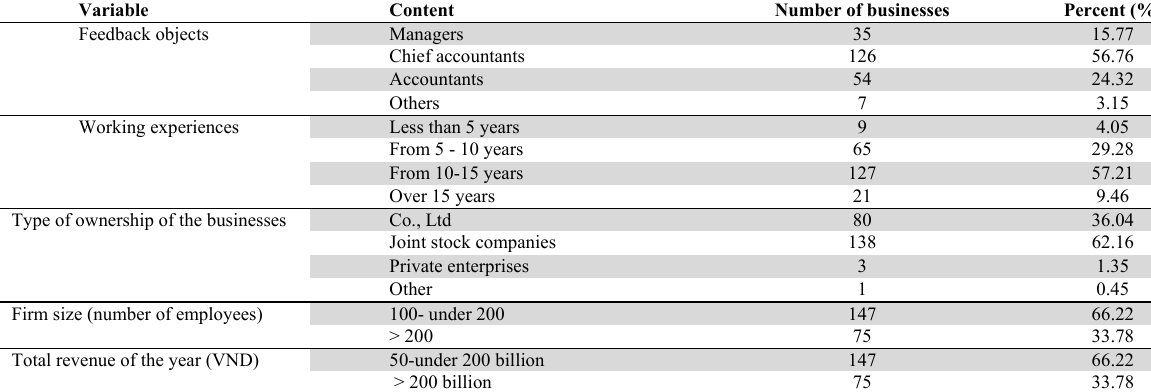
Descriptive statistics results